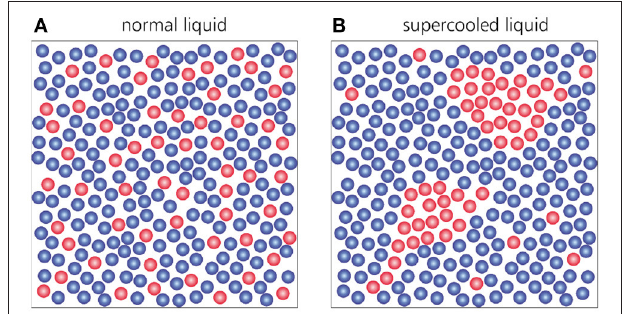
FIGURE 4 | Illustration of dynamic heterogeneity in supercooled liquids. The red-colored particles represent mobile particles that have moved further than a certain distance 1 r during a time interval 1 t , while blue-colored particles represent particles that have moved less than this distance in the same time interval. In the normal liquid phase (A) , particle motion occurs rather homogeneously across the entire sample. Conversely, in a supercooled liquid (B) , particle motion occurs heterogeneously in clusters of collectively moving particles, and the appearance of such mobile clusters fluctuates both in space and in time. The figure is based on Weeks et al. [